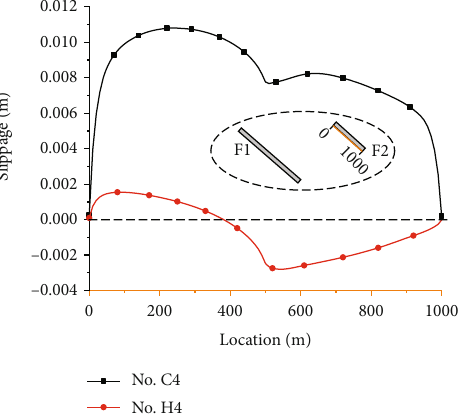
Figure 14: The fault slippage of F2 according to di ff erent fracturing regions (Nos. C4 and